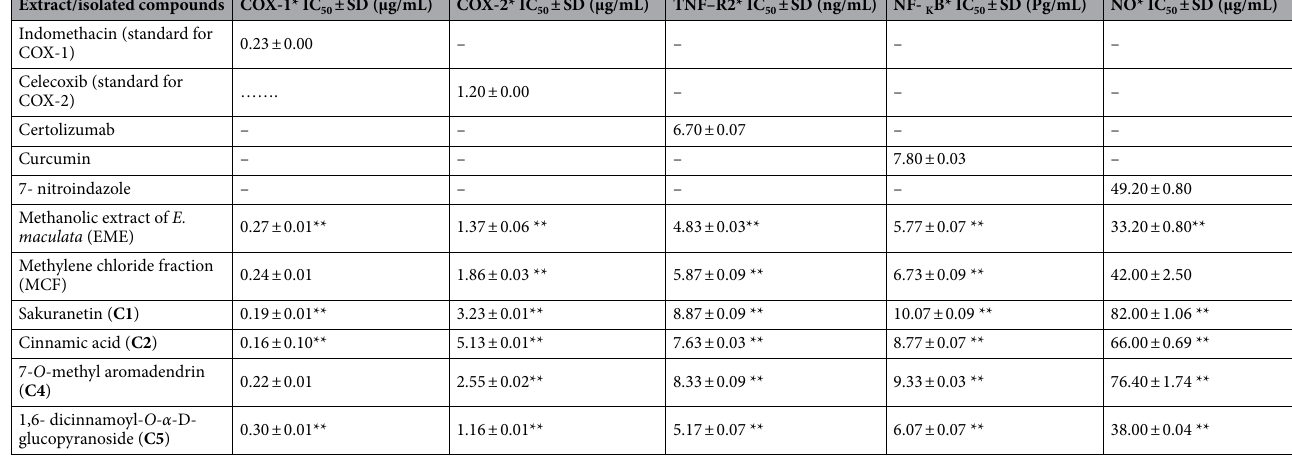
Table 1. COX-1, COX-2, NF- K B and NO inhibitory activity and TNF-R2 binding activity (IC 50 ) of EME, MCF and selected isolated compounds. *Average of three determinations. (**) Significantly different (P < 0.05) compared to reference drug using sample t-test and using the SPSS 26.0